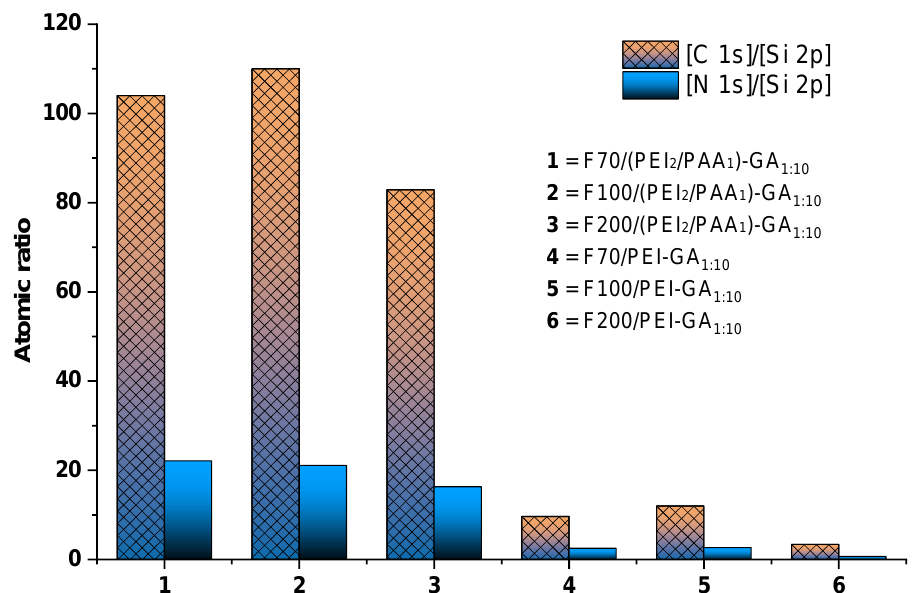
Figure 5. Atomic ratios calculated from XPS survey spectra for composite sand fractions, before (1, 2, 3) and after (4, 5, 6) the extraction of non-crosslinked polyelectrolyte chains in acid-base